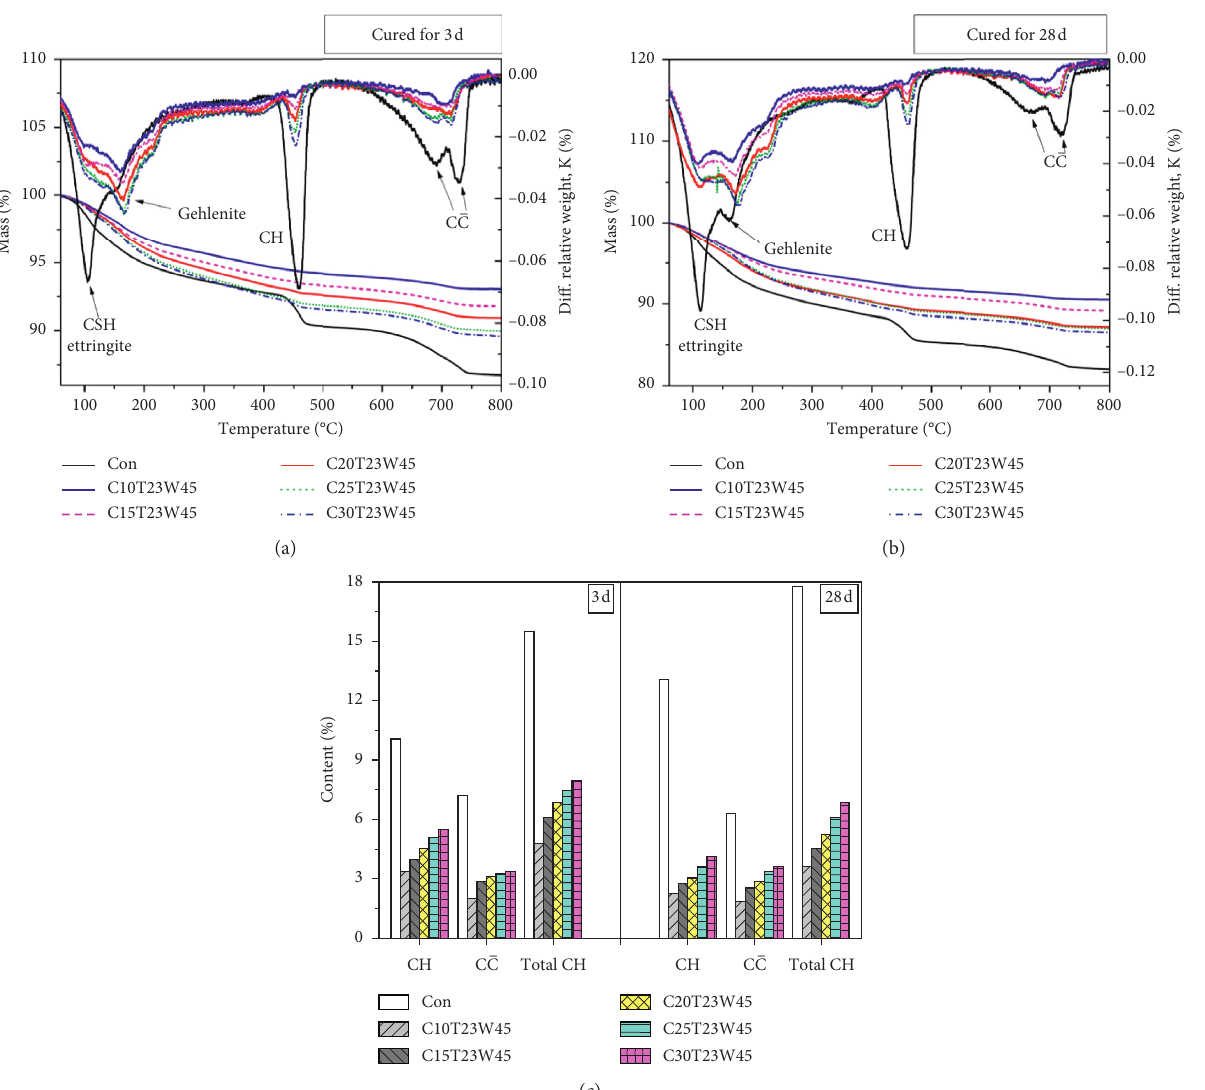
Figure 4: Hydration products of pastes with different contents of cement: (a) TGA-DTG results of 3d pastes; (b) TGA-DTG results of 28d pastes; (c) calculated contents of CH or CC ( — ) or total